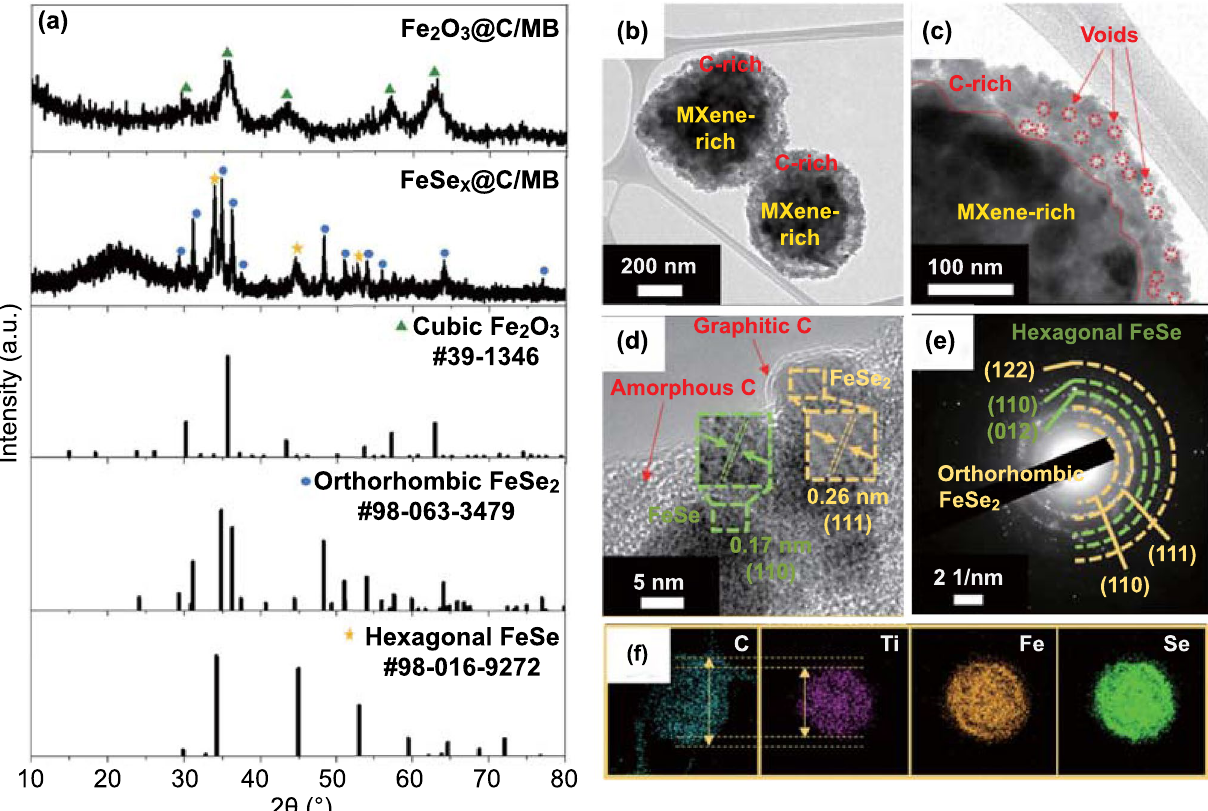
Fig. 1 a XRD patterns of Fe 2 O 3 @C/MB and FeSe x @C/MB, b, c TEM images, d HR‑TEM image, e SAED pattern, and f elemental mapping images of FeSe x